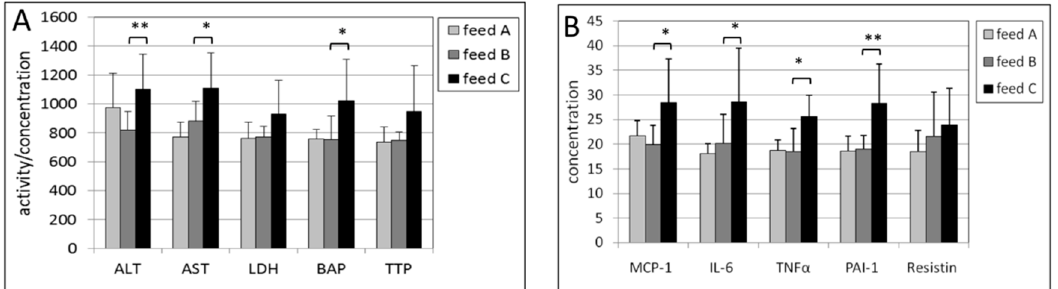
Figure 5. ( A ) Activities of ALT, AST and LDH, and concentrations of BAP and TTP in the post-mitochondrial supernatant of kidney tissue of male mice. The levels of ALT, LDH, BAP and TTL were multiplied by a factor of 10, 0.1, 5 and 20, respectively, to fit in the figure; ( B ) Concentrations of MCP-1, IL-6, TNF- α , PAI-1 and resistin in the post-mitochondrial supernatant of kidney tissue of male mice. The levels of MCP-1, IL-6, TNF- α and resistin were multiplied by a factor of 5, 10, 20 and 0.25, respectively, to fit in the figure. The levels of feed B were tested statistically relative to those of feed A, and the levels of feed C relative to those of feed B. * p < 0.05, ** p < 0.01.